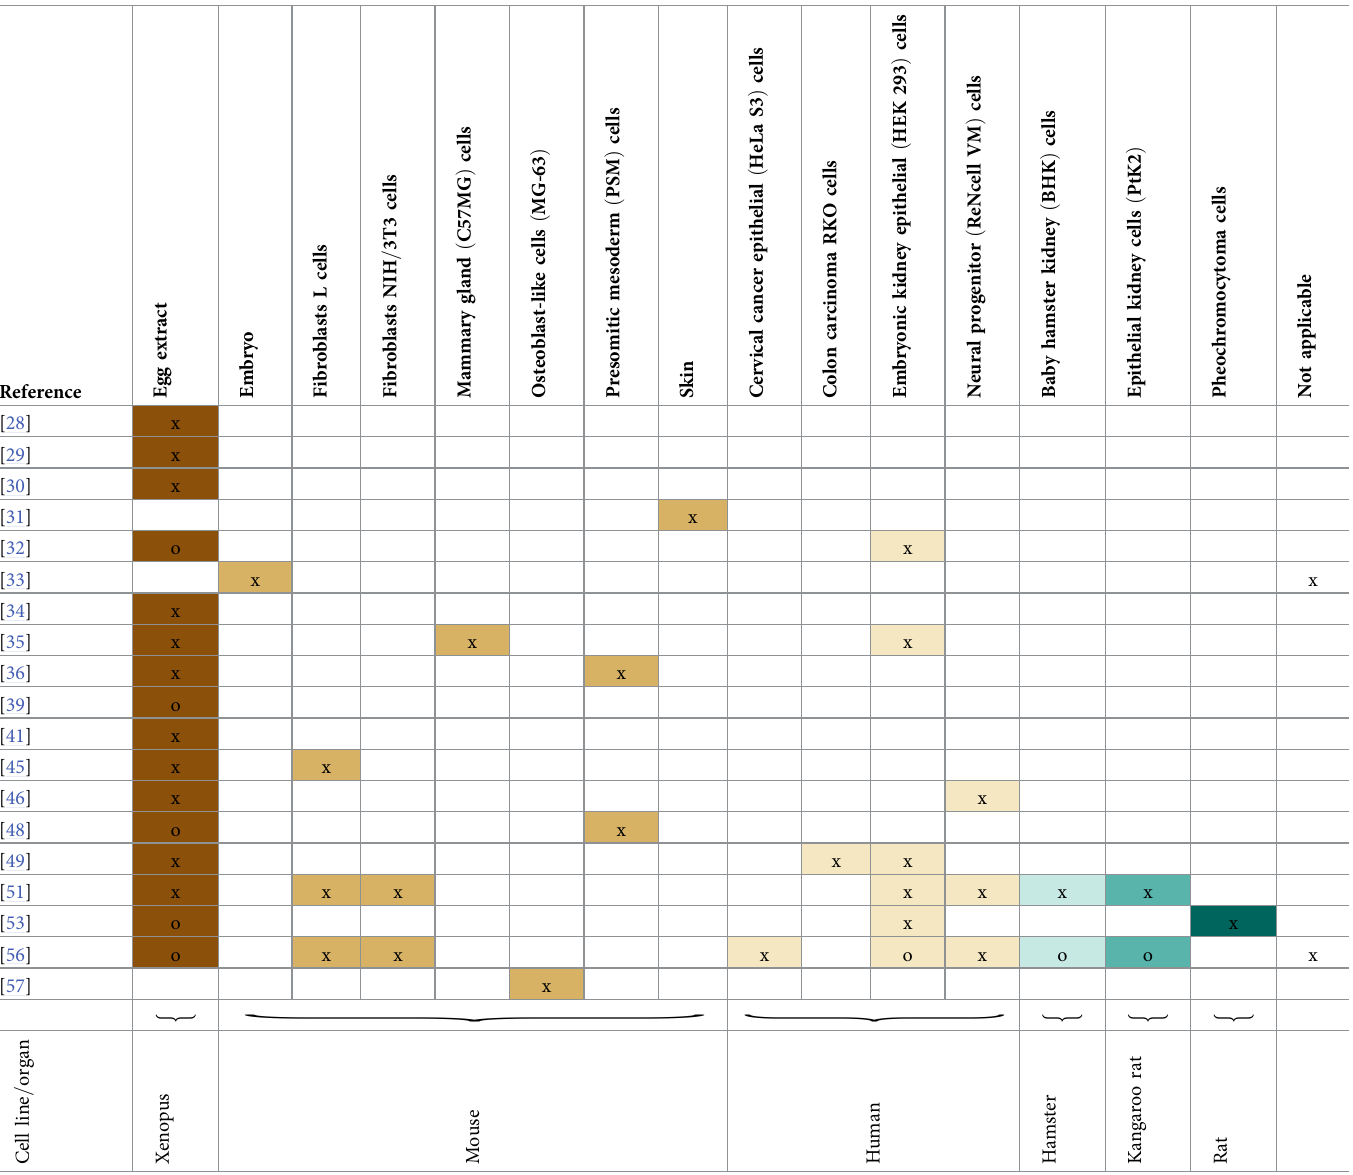
Table 3. Cell lines and organisms used building the simulation models.